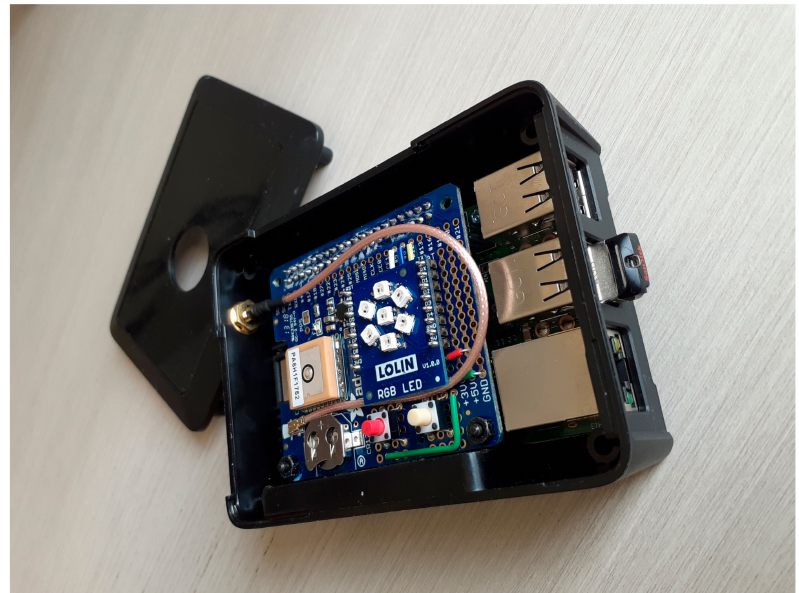
Figure 2. Raspberry Pi main system device showing USB flash drive, GPS hat, RGB LED status array, and GPS